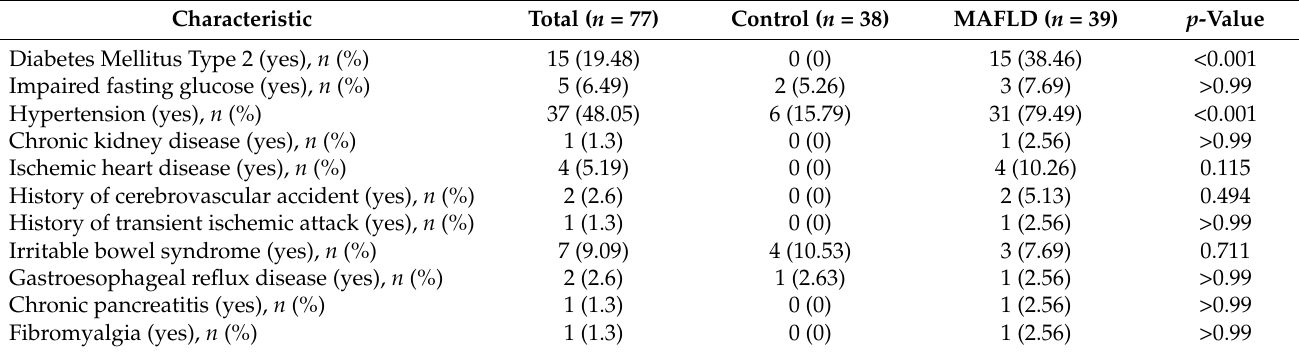
Table 2. Associated comorbidities of